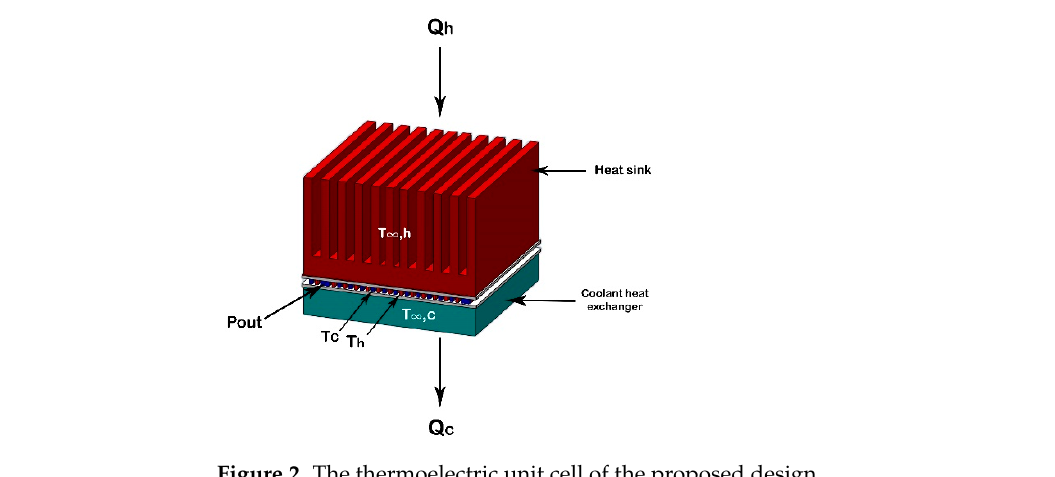
Figure 2. The thermoelectric unit cell of the proposed design.